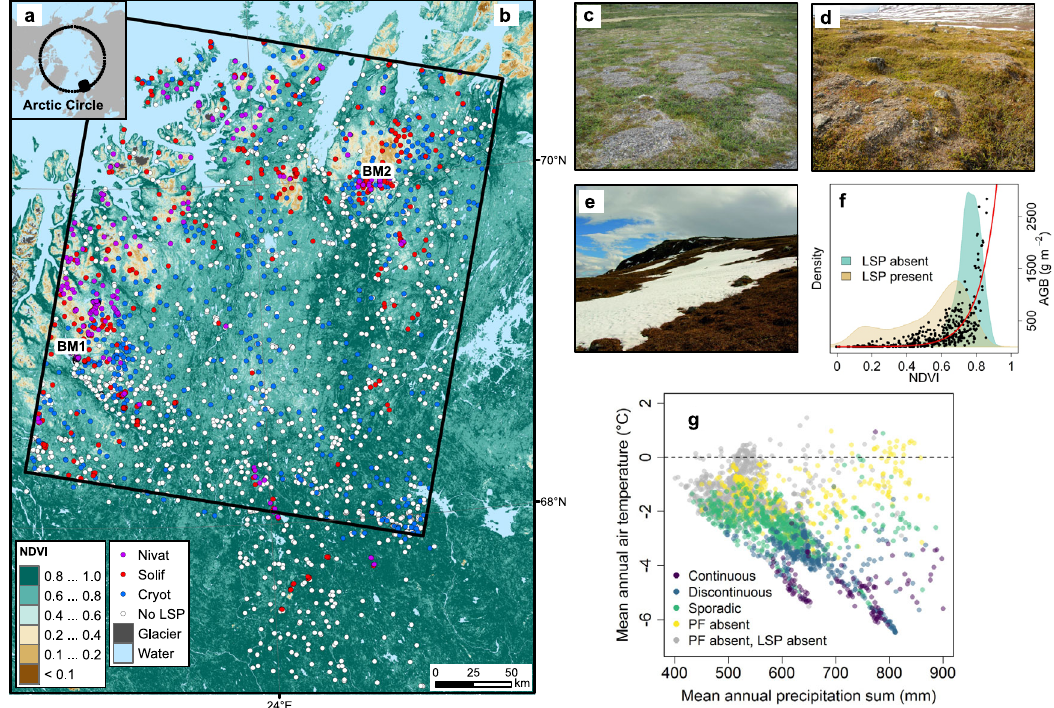
Fig. 1 The study area and observation sites, and their climatic coverage. a Location of the study area (black box) in respect to the circum-Arctic region. b Normalized difference vegetation index (NDVI) overlain by observation sites ( n = 2917) and type of LSP (Nivat = nivation, Solif = soli fl uction, Cryot = cryoturbation). The black rectangle indicates the model prediction domain. c – e show fi eld photos of typical surface features of LSP: cryoturbation (frost-churning), soli fl uction (soli fl uction lobes) and nivation (snow accumulation sites), respectively. f the relationship between AGB measured in-situ (sampling regions are labeled as “ BM region 1 ” and “ BM region 2 ” , total number of measurements is 433) and NDVI; the red line depicts a fi tted generalized least squares function used to estimate AGB for the LSP sites (Methods). The kernel smoothed NDVI distributions in the presence of any of the three LSP ( n = 1440) and absence of all LSP ( n = 1477) are shown in the background. g Permafrost (PF) conditions at each LSP observation site according to a recent ground thermal modeling 26 . The PF categories continuous, discontinuous, sporadic, and PF absent are associated with the presence of at least one LSP, whereas the last category (PF absent, LSP absent) does not include any LSP.